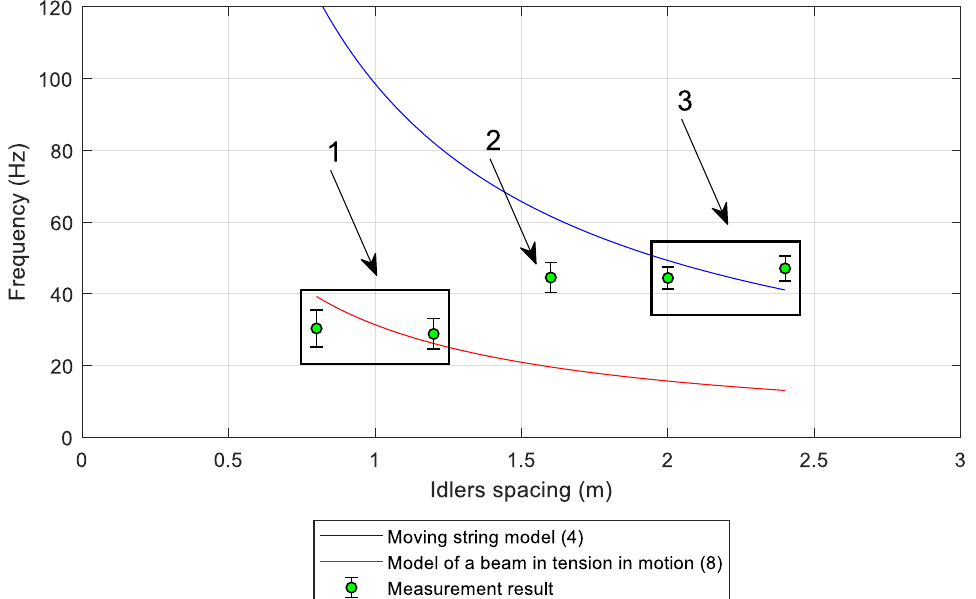
Figure 8. The measured frequency of transverse vibrations in the ST800 belt as a function of idler support spacing for a constant belt linear speed (2.4 m/s) and for a constant tensile force (40 kN), compared with the values predicted for the moving string model and for the model of a moving beam in tension: 1 — area of optimal prediction from the beam model, 2 — intermediate point with a significant error from both models, and 3 — area of optimal prediction from the string model.